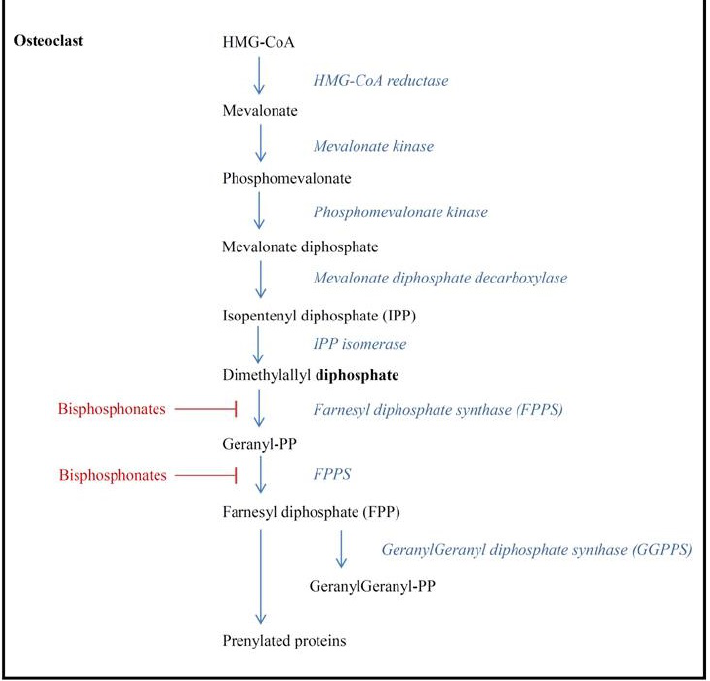
Figure 1. Mevalonate pathway and inhibition of farnesyl diphosphate synthase by